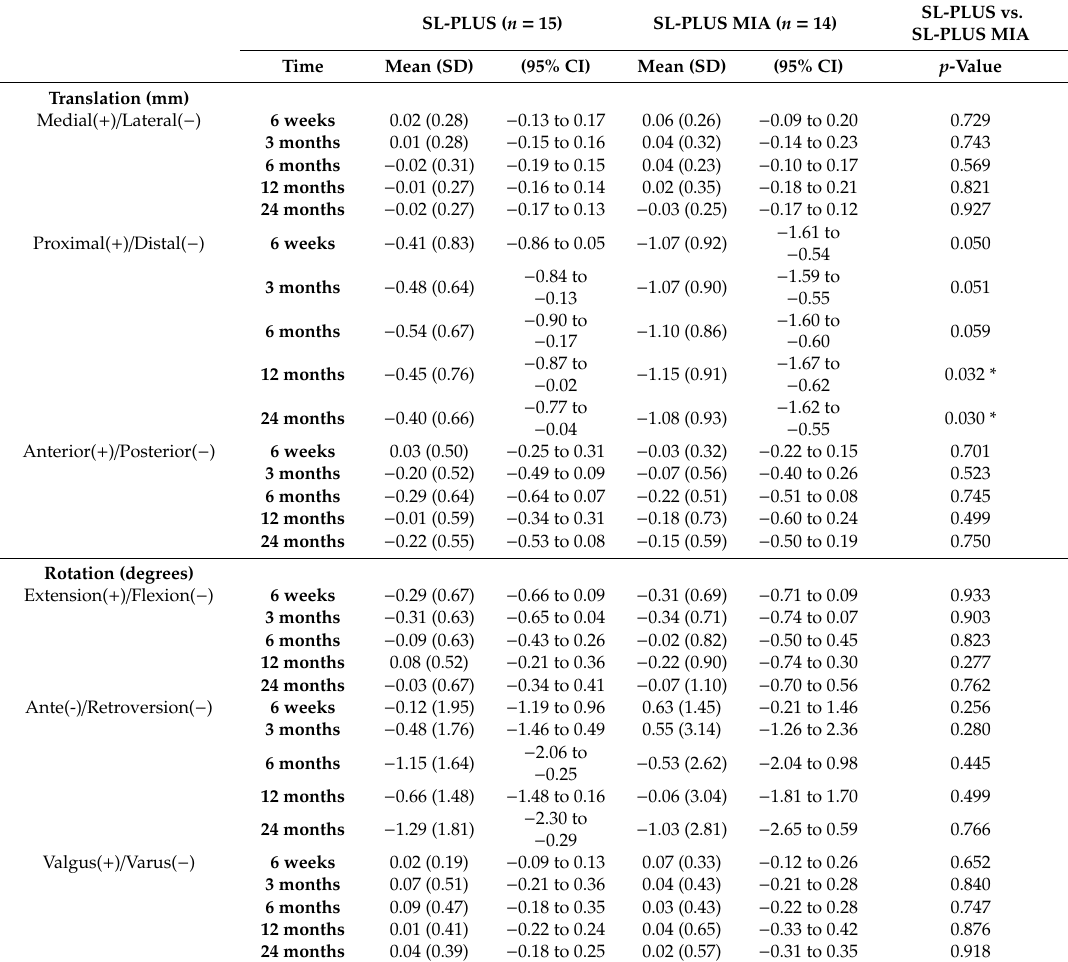
Table 3. Results of RSA measurements showing femoral stem migration for both groups at each follow-up